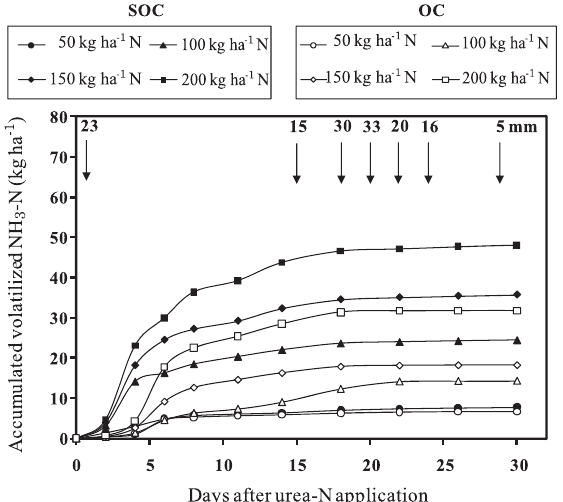
figure 3. Cumulative volatilized nH 3 -n in 30 days after fertilization, as estimated by two collection methods: a semi-open static collector (soC) and an open collector with an absorber wrapped in ptfe film (oC). the arrows indicate rainfall events, and the numbers above them indicate the rainfall quantity (mm).